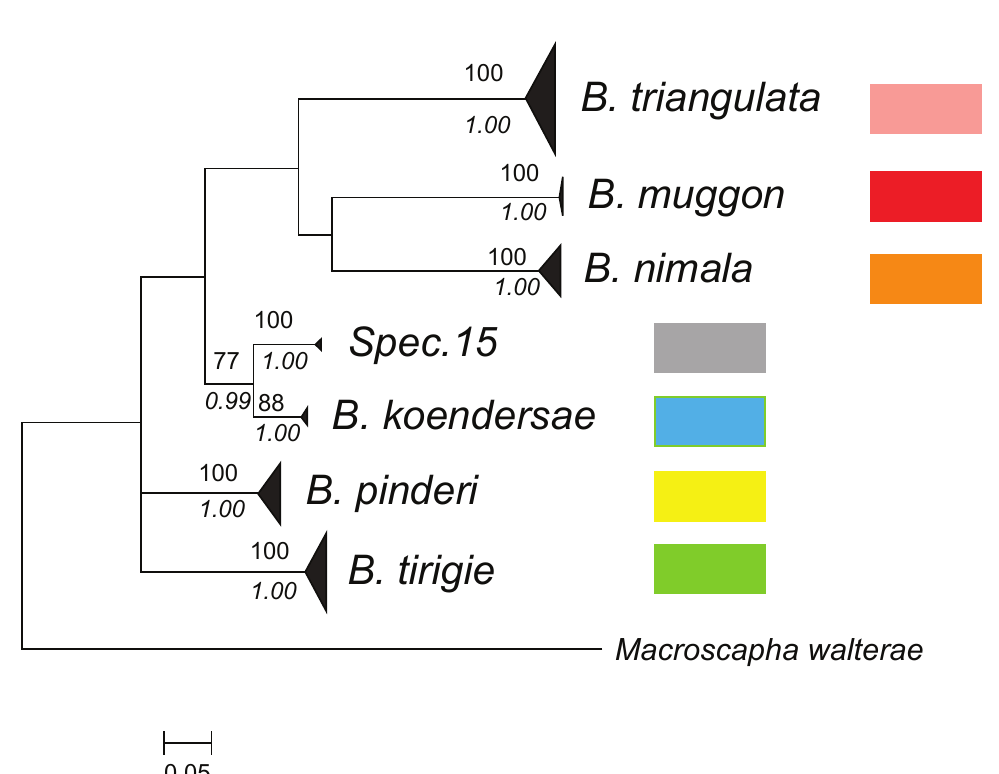
Fig. 2. Phylogenetic tree constructed with Bayesian Inference (BI) and Maximum Likelihood (ML) methods from cOI sequences belonging to a total of 54 ostracods from the Bennelongia nimala and B. triangulata lineages, respectively, with the marine ostracod Macroscapha walterae from Genbank (accession number GU566887) as outgroup. Numbers above and below nodes illustrate statistical support for this particular node. Numbers above nodes are % bootstrap values of ML analyses with 1000 replicates, numbers below nodes in italics represent Bayesian posterior probabilities (ranging from 0 to 1). Both methods, BI and ML, resulted in the same tree topology. Different phylogenetic clades are indicated by